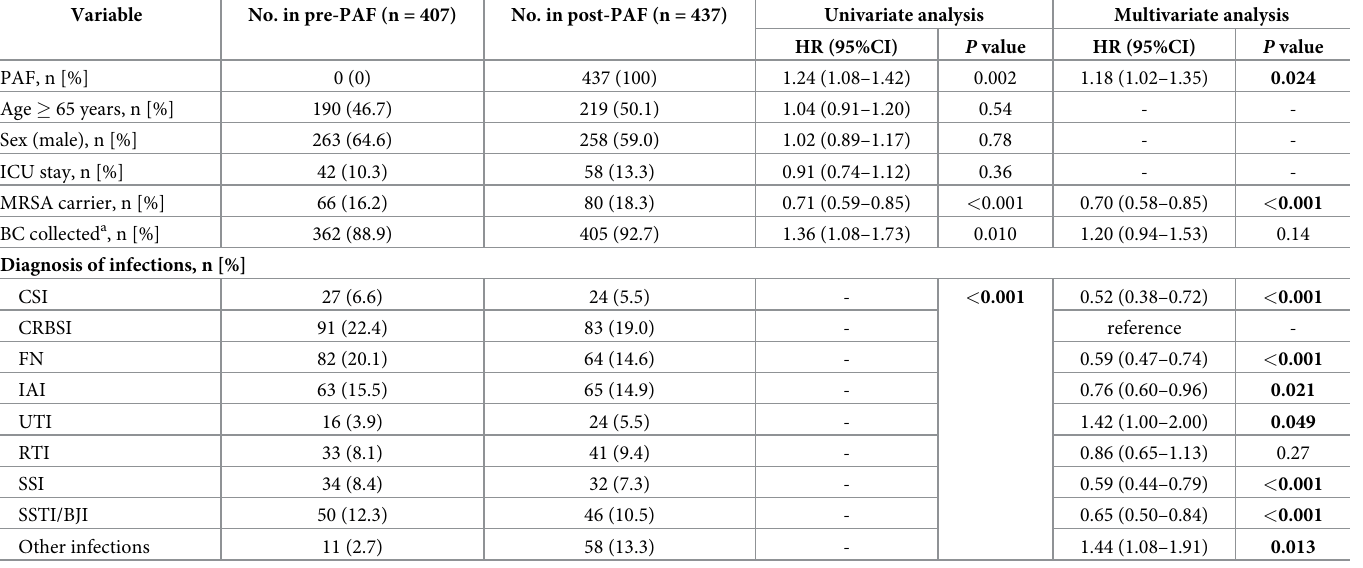
P values that represent a significant difference are highlighted in bold. a BC samples collected before the administration of anti-MRSA agents.